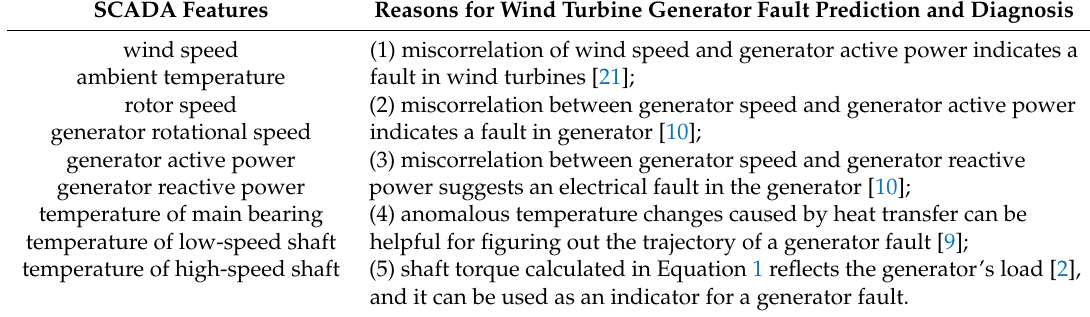
Table 5. Features and reasoning rules for predicting the remaining useful life (RUL) and fault diagnosis of the wind turbine